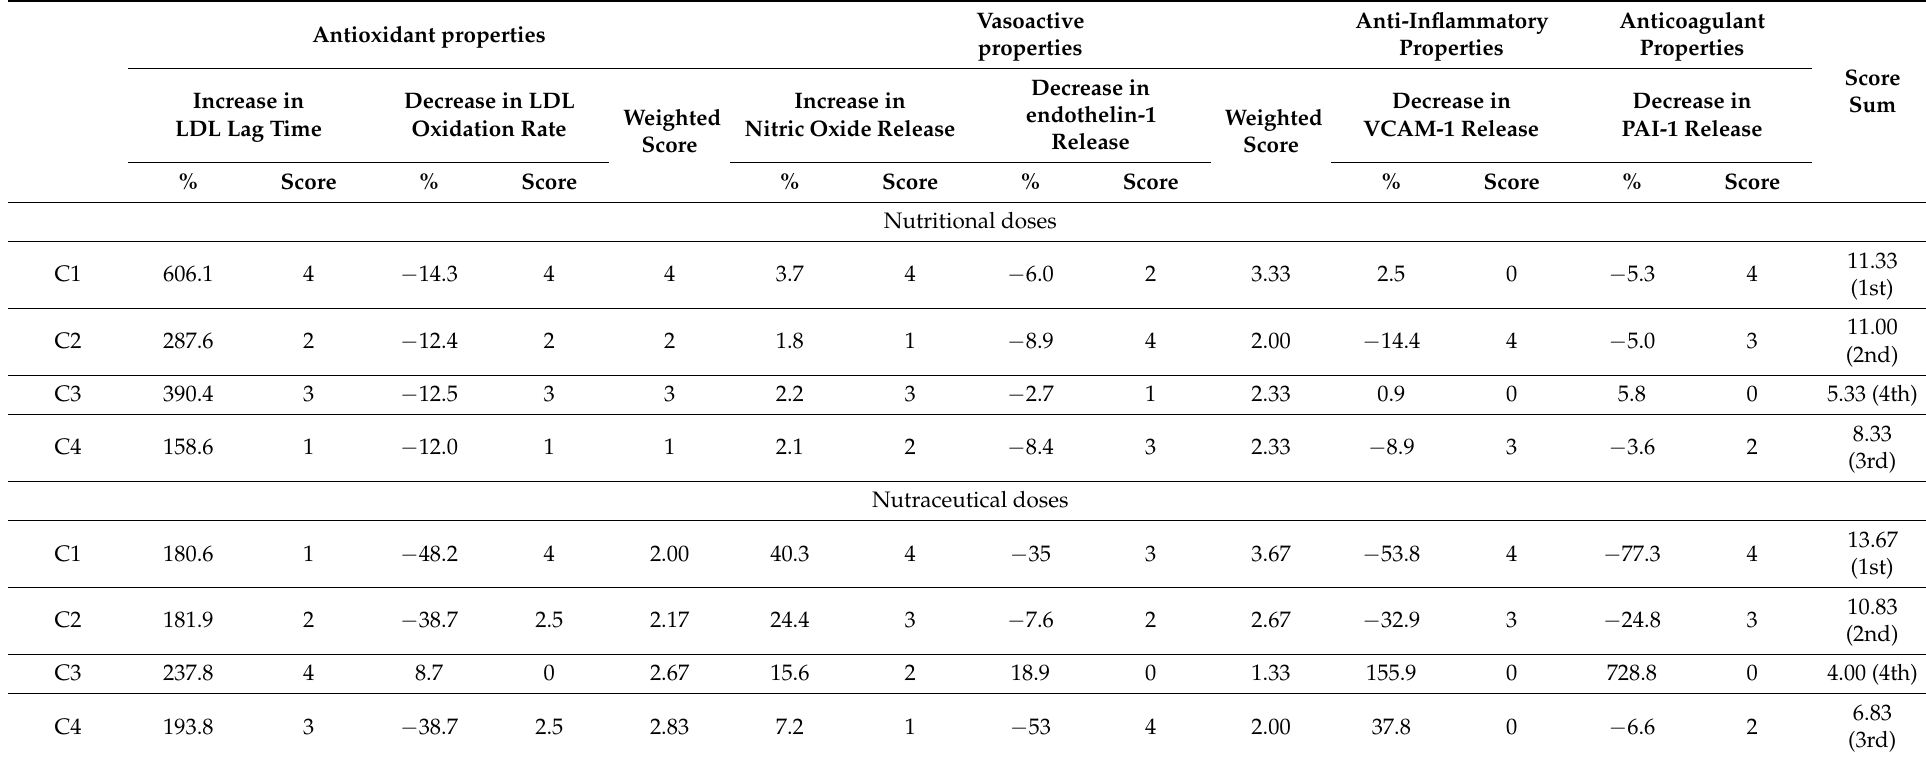
Table 3. Effects of extract combinations 1